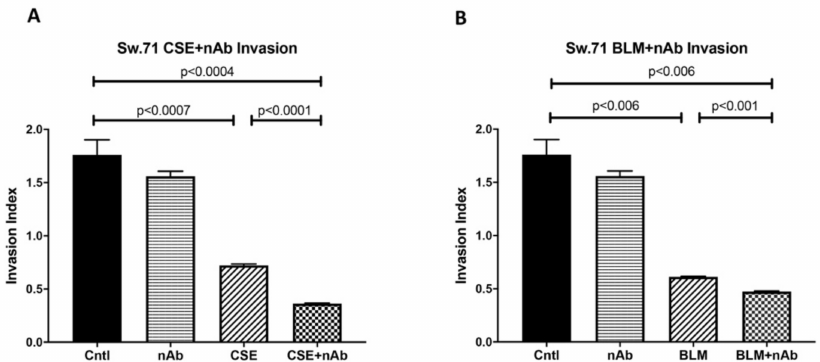
Figure 9. Trophoblastic dysfunction as a consequence of genomic instability. ( A ) Decreased invasion in CSE treated Sw.71 cells and further hindrance in invasion when nAb was co-treated with CSE. ( B ) Decreased invasion in BLM treated Sw.71 cells, the invasion further diminished when nAb was co-treated with